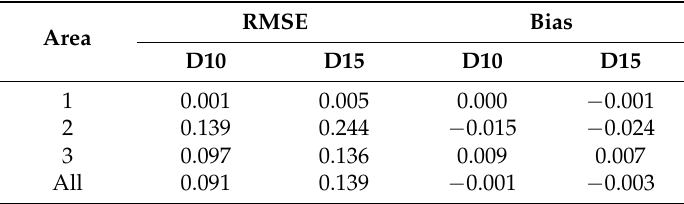
Table 4. Summary statistics of single-tree position estimated by D10 and D15 scans. Root mean square error (RMSE) and bias are reported in